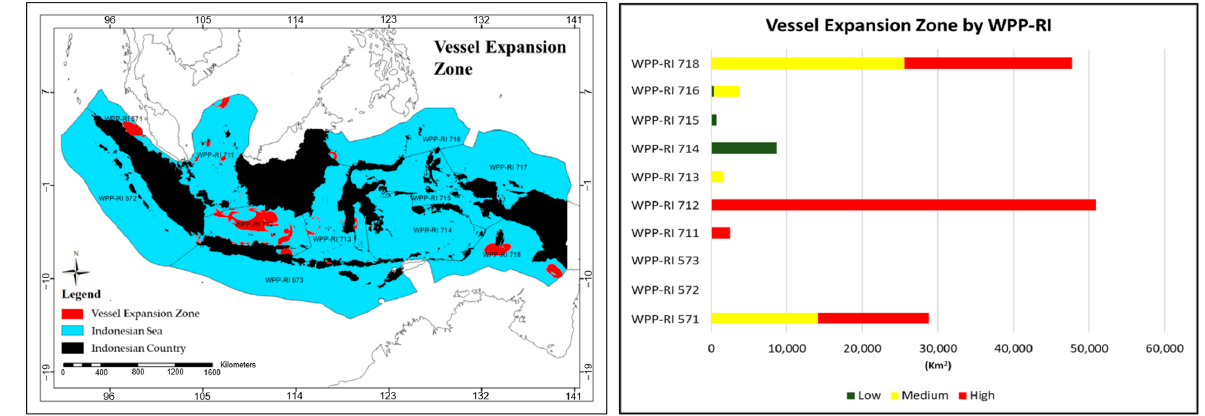
Figure 6. Map and plot depicting the vessel expansion zone in the Indonesian Fisheries Management Zone (IFMZ) between 2013 and 2018.